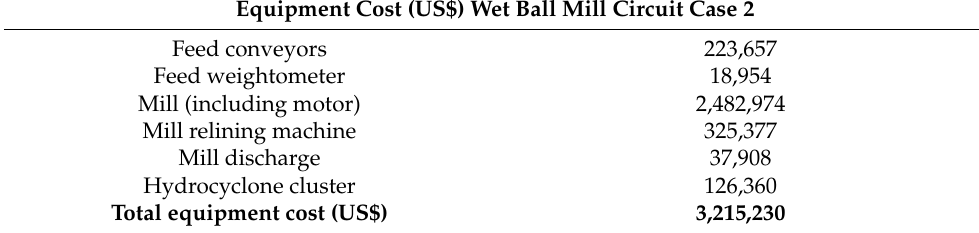
Table 5. The equipment cost for Case 2.